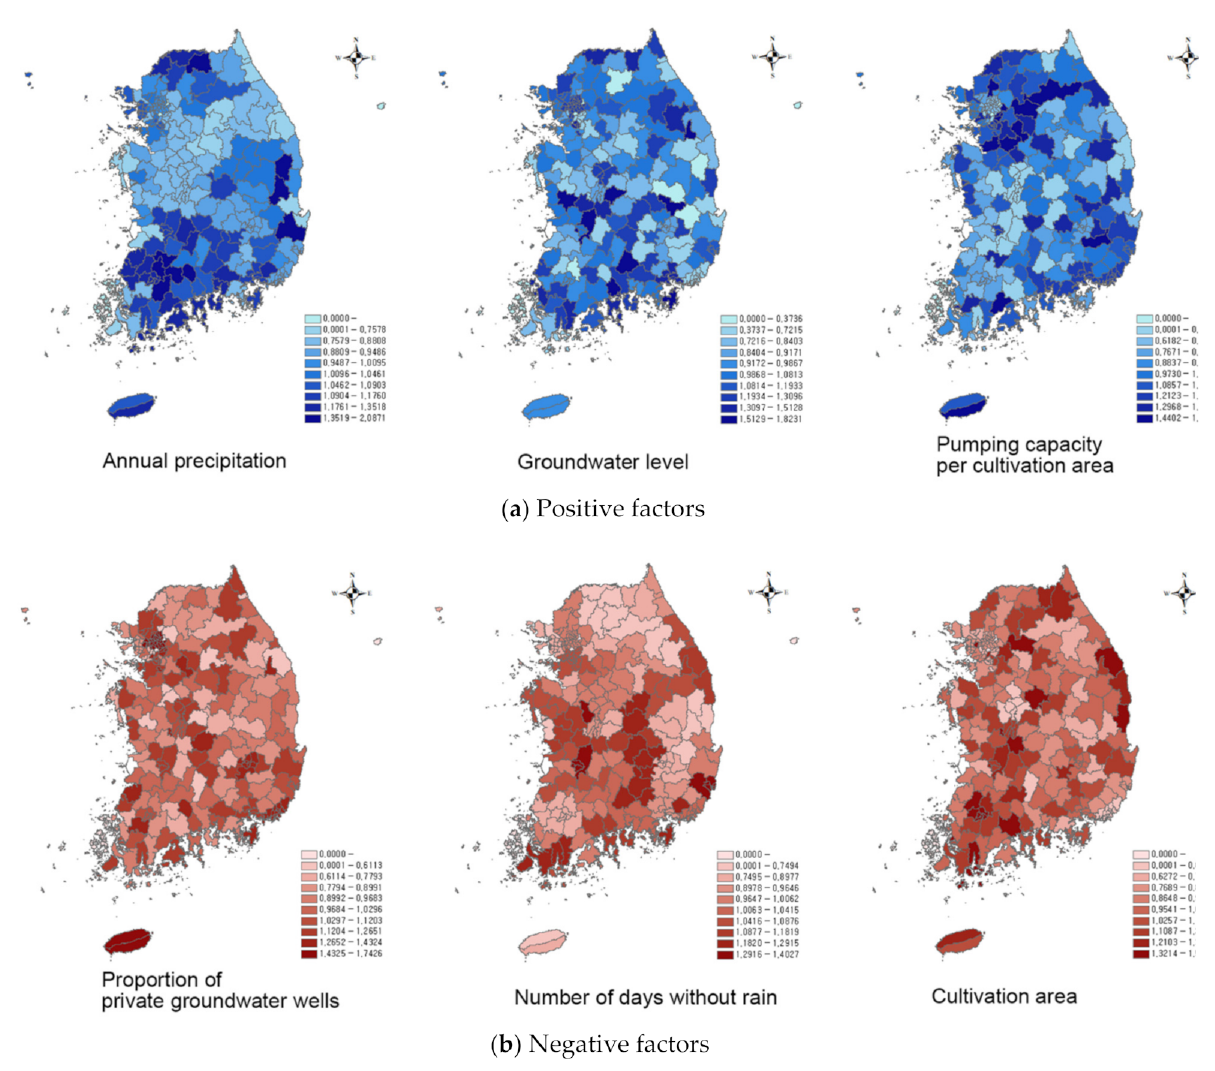
Figure 2. The study datasets ( a ) Positive factors and ( b ) Negative